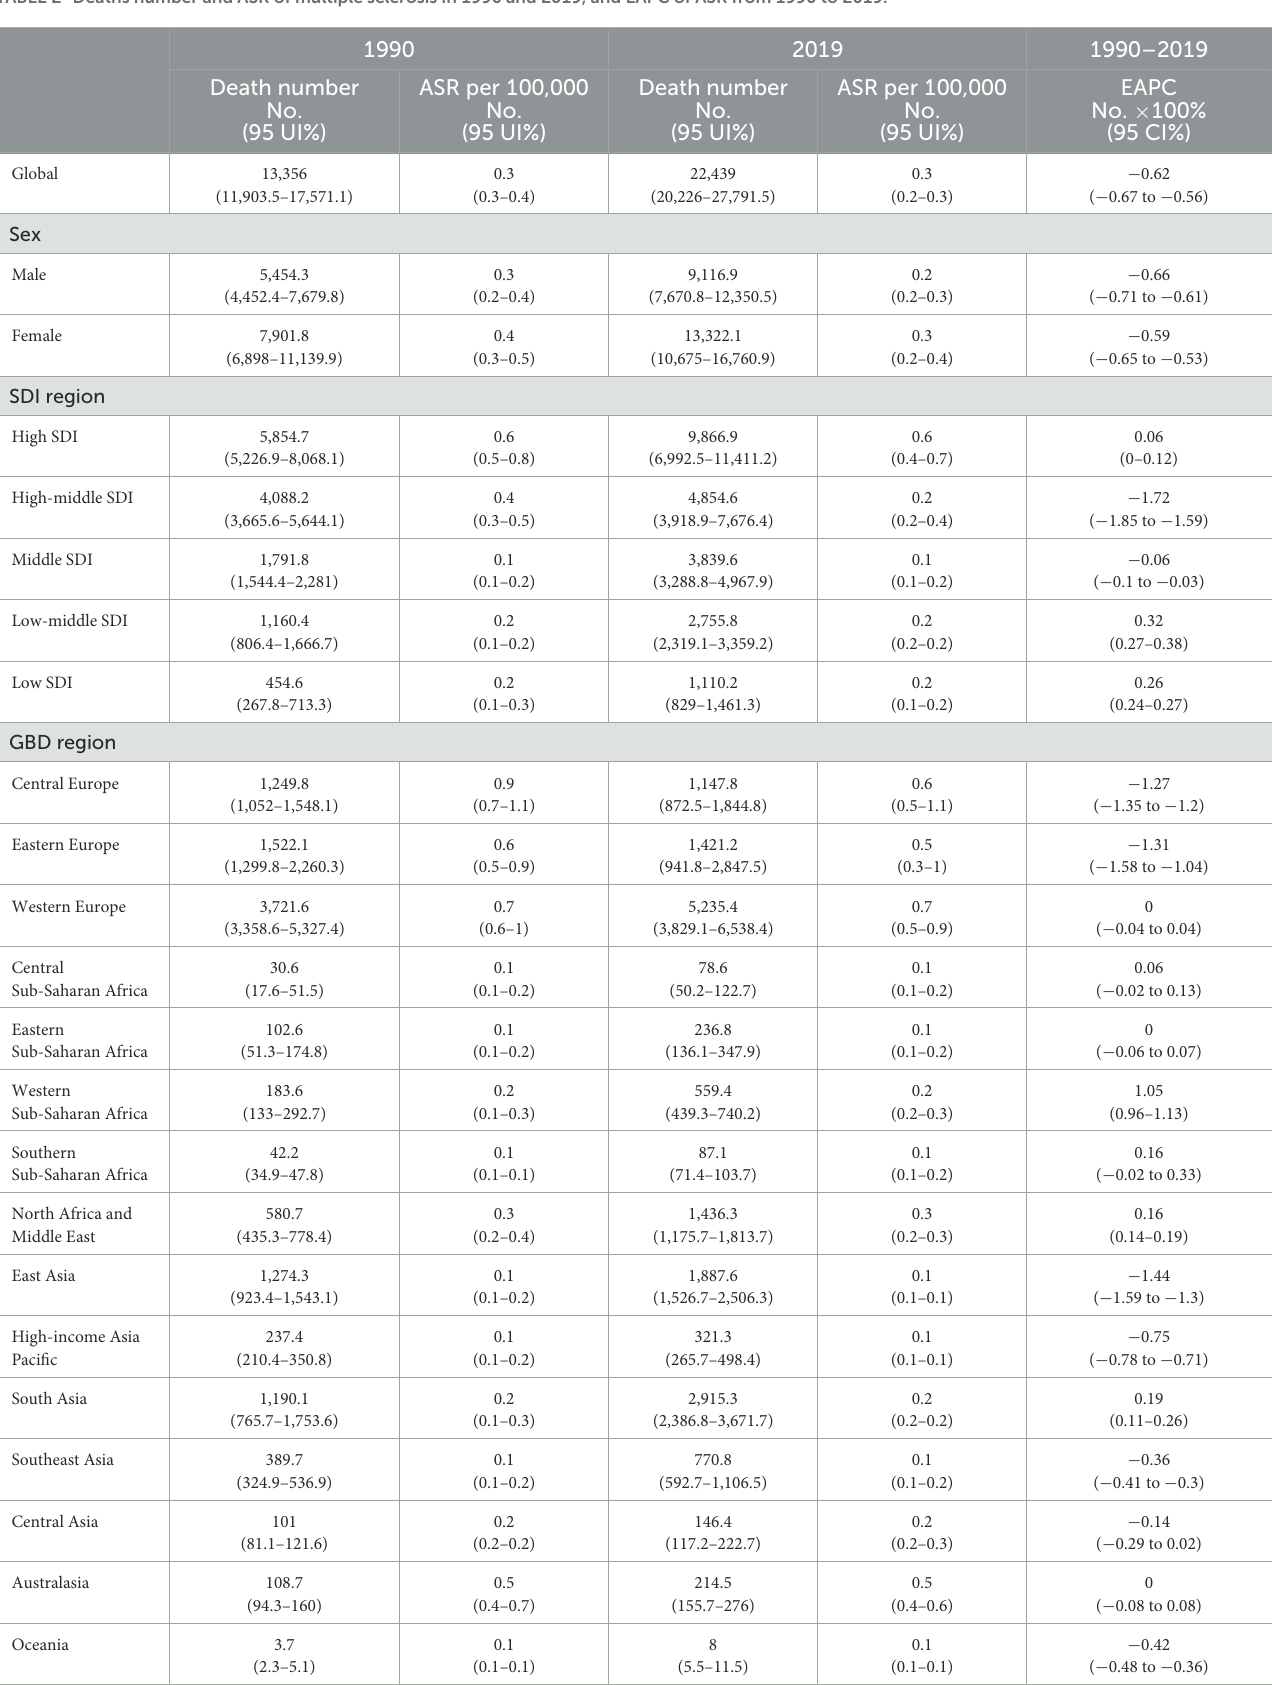
TABLE 2 Deaths number and ASR of multiple sclerosis in 1990 and 2019, and EAPC of ASR from 1990 to